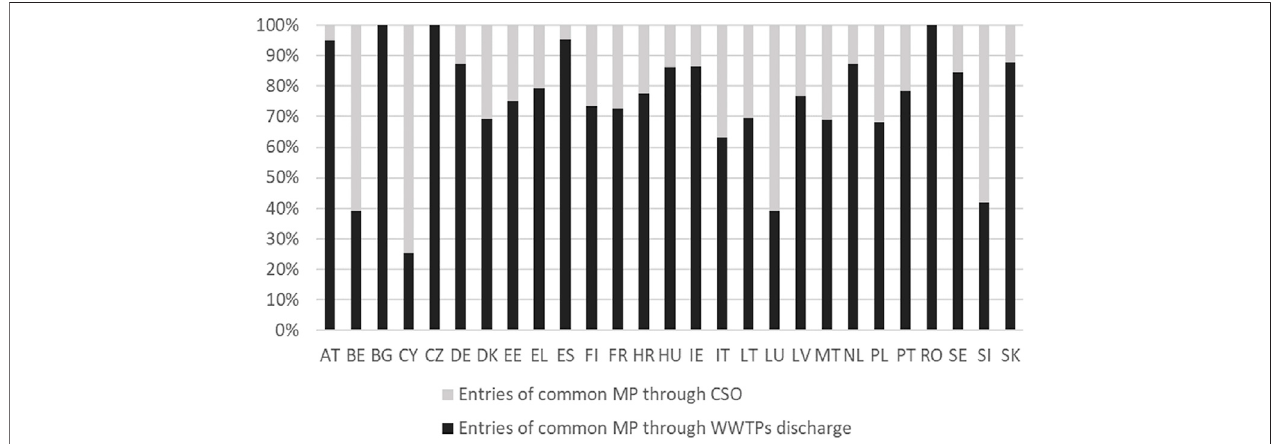
FIGURE 3 | Share of WWTP discharge and CSO regarding the environmental input of common MP (some MS do not report plausible CSO data/CS ratio data). Labels on the x -axis refer to country codes ( Table 2 ).